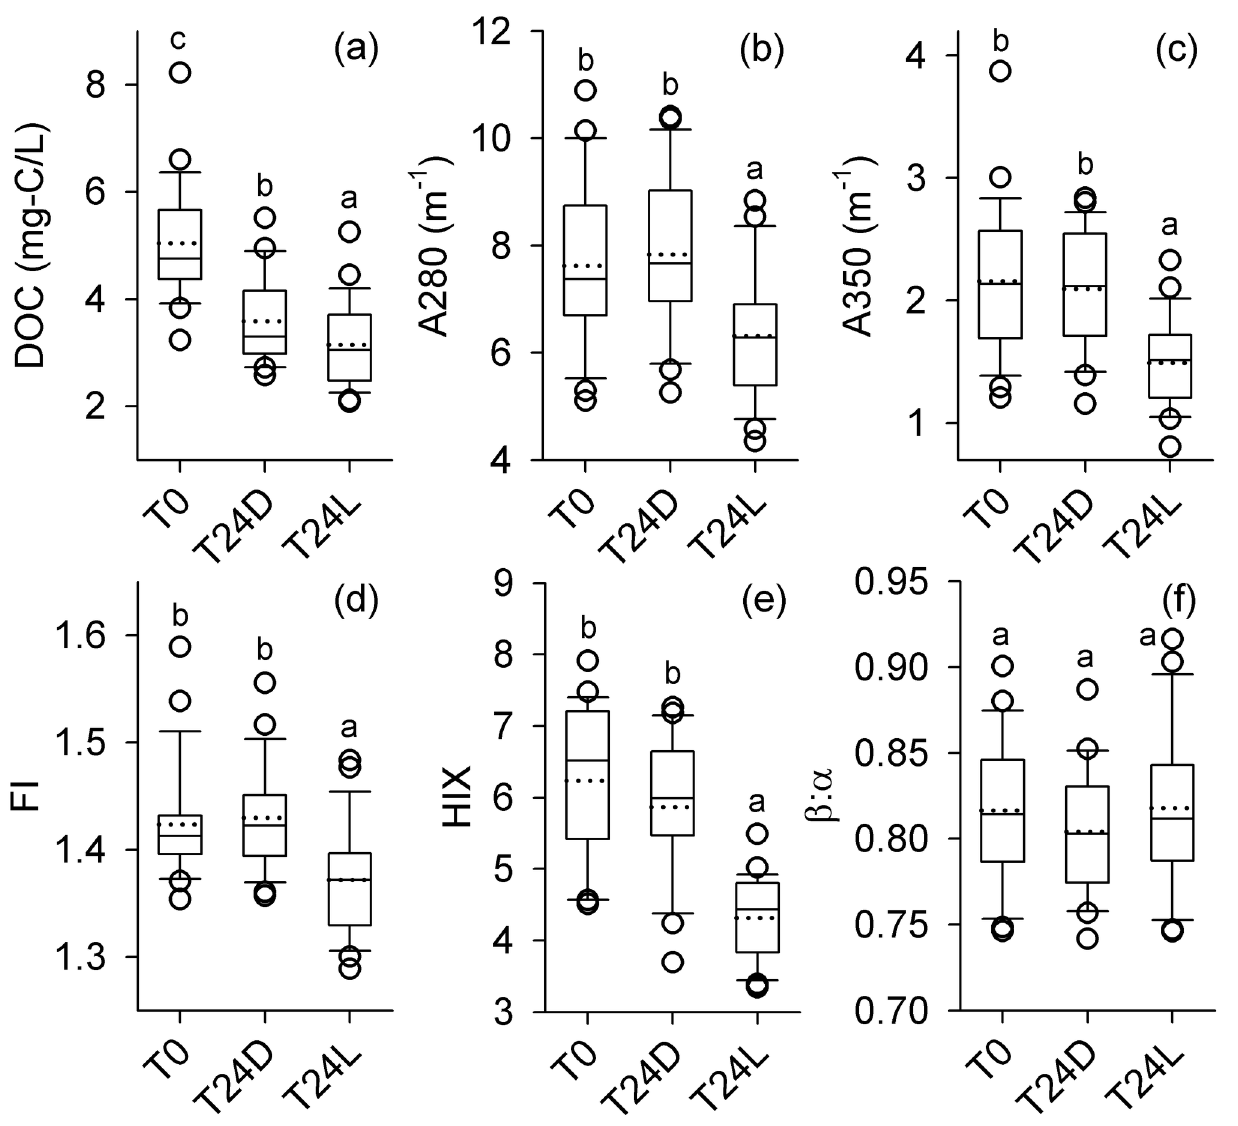
Figure 2. Effects of photo-irradiation on urban pond dissolved organic matter. Box plots showing the median (solid line), 25 th and 75 th percentiles (boxes) and 10 th and 90 th percentiles (dots) for absorbance (A concentrations and measured fluorescence indices (d) FI, (e) HIX and (f) β:α for 25 urban ponds in August, prior to photo-irradiation (T0) and for light treatment (T24L), and dark treatment (T24D). Values denoted with different letters are significantly different ( p